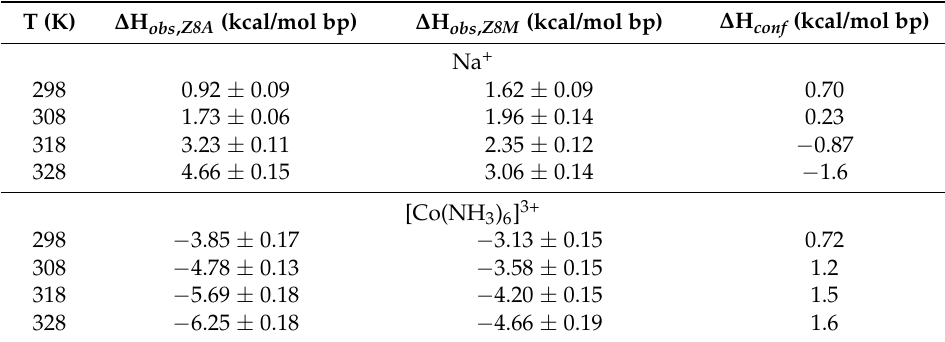
Table 1. Summary of ITC determined enthalpies for the titrations of Z8A and Z8M.